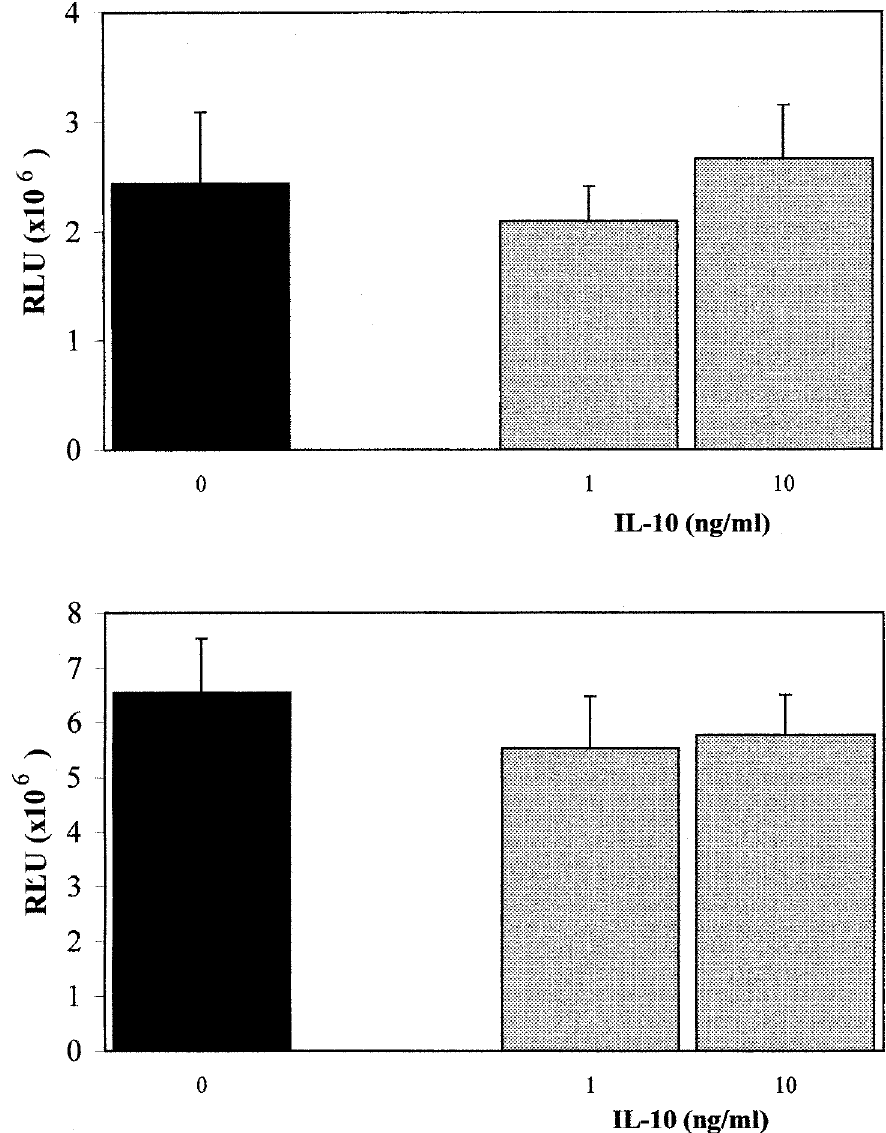
FIG. 4. Effects of interleukin 10 (IL-10) (1 and 10ng/ml) or vehicle on fMLP-induced increased in superoxide anion production (expressed in relative light units (RLU)) from peripheral blood mononuclear cells pretreated (lower panel) or not (upper panel) with lipopolysaccharide ( n =